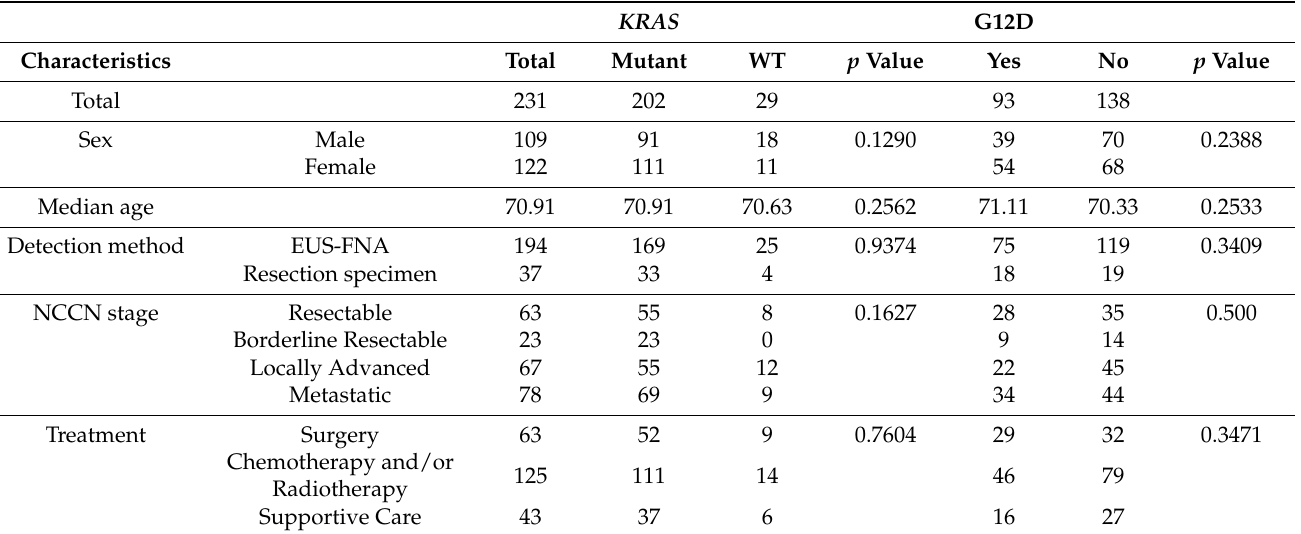
Table 2: Patient characteristics of whole cohort. Number from each group displayed. Correlation assessed using chi-square test with Yates’ continuity correction and Fisher’s exact test. WT, wild-type; EUS-FNA, endoscopic ultrasound fine needle aspirate; NCCN, National Comprehensive Cancer Network. Table 2. KRAS mutation subtype frequency.